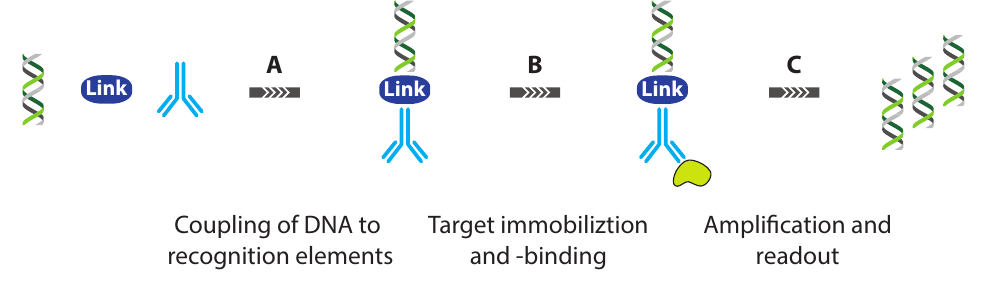
Figure 4. Schematic overview of IPCR where dsDNA is coupled to an antibody through the use of various linkers ( A ). Target binding ( B ) and subsequent amplification of the dsDNA label allows for sensitive quantification of the target ( C